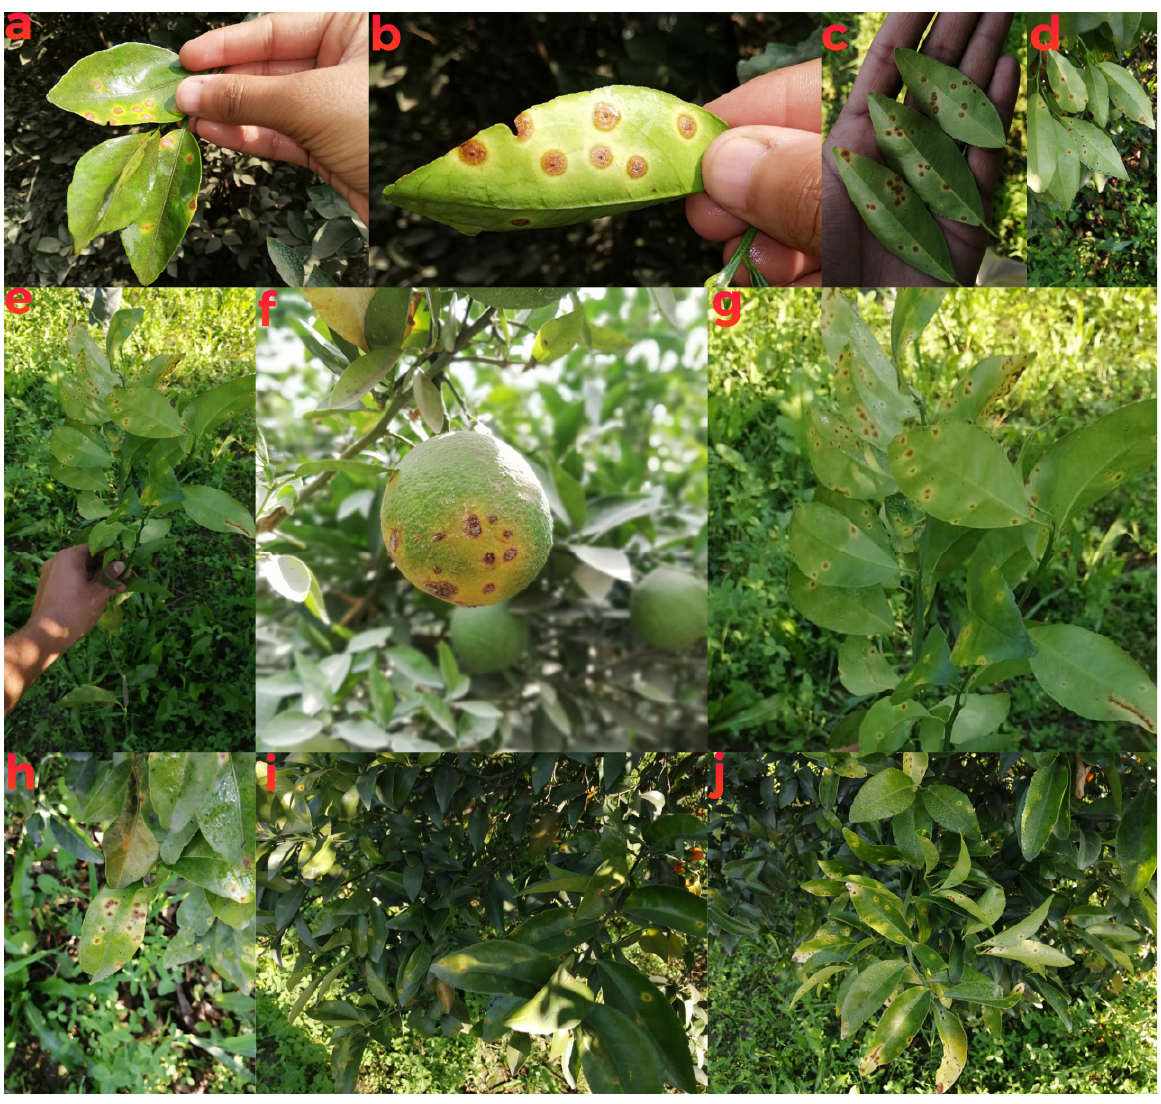
Figure 2. Raised blister-like brown spots with oily or water-soaked appearance surrounded by a yellow halo ring on citrus leaves ( a ); round, sunken, discolored, swollen, cracked, flattened and necrotic areas of lesions on leaves ( b ); irregular lesions on back side of leaves ( c ); scattered canker lesions on lower side of leaves ( d ); twig showing canker lesions scattered ( e ); canker blisters upon citrus fruit ( f ); a large branch part showing canker lesions ( g ); cankerous lesions on lower leaves of tree ( h ); scattered canker lesions on upper and lower sides of leaves ( i );lateral leaves showing cankers ( j ).